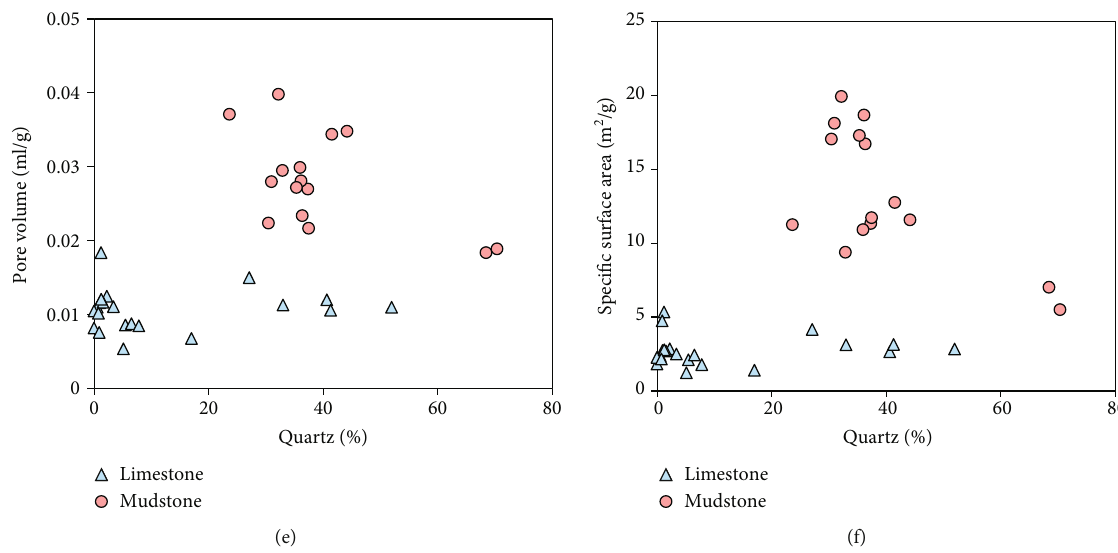
Figure 11: The correlation between organic matter abundance, mineral composition, and pore